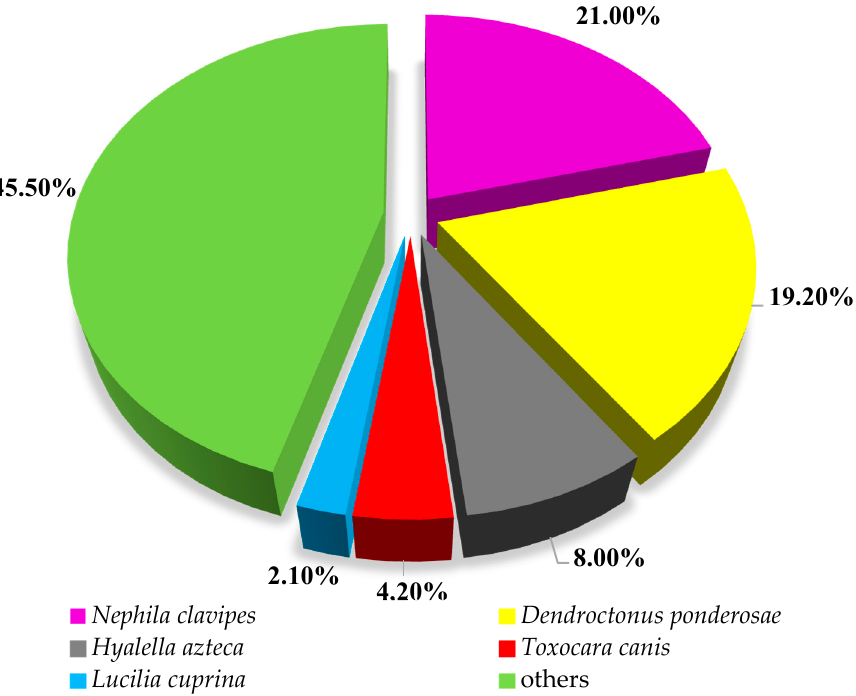
Figure 1. The unigene BLASTx searches against the Nr database for species distribution analysis.